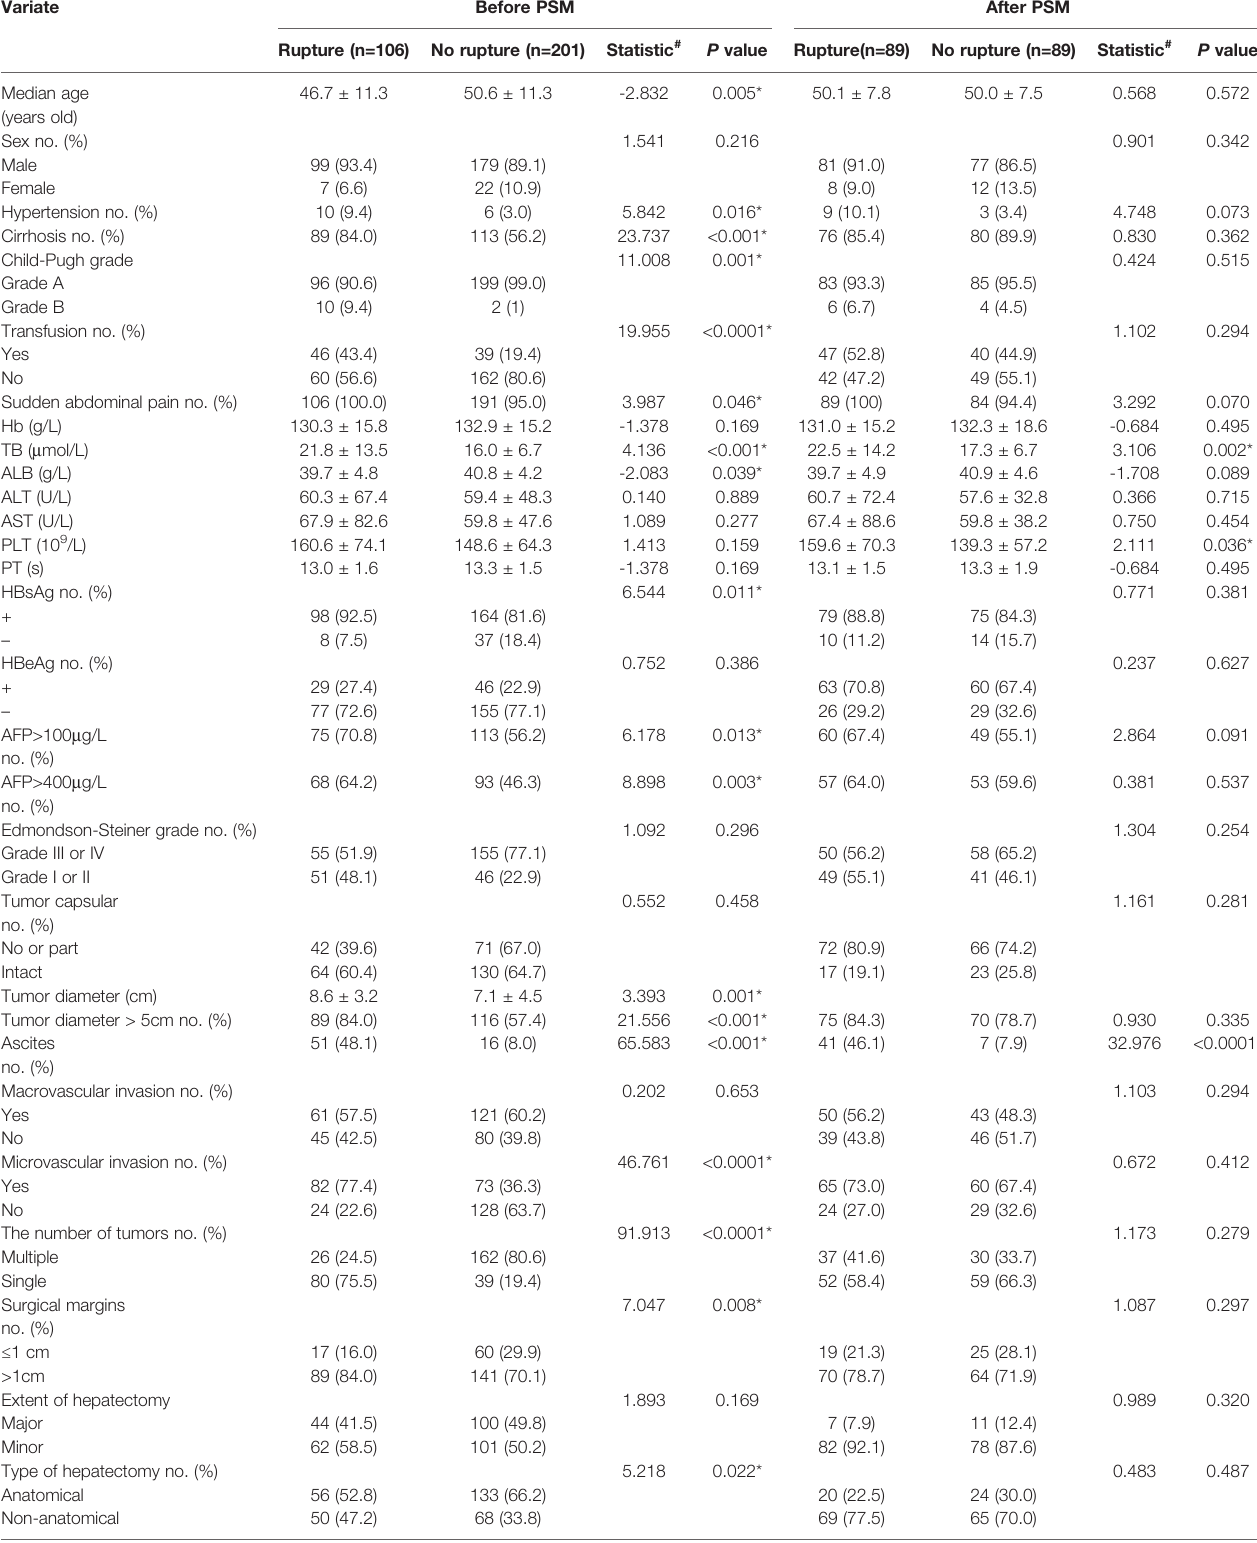
TABLE 1 | Comparison of clinical characteristics between HCC patients with STR and those with nonruptured tumors undergoing hepatectomy. Variate Before PSM After PSM Rupture (n=106) No rupture (n=201) Statistic # P value Rupture(n=89) No rupture (n=89) Statistic # P value Median age (years old) Sex no. (%)